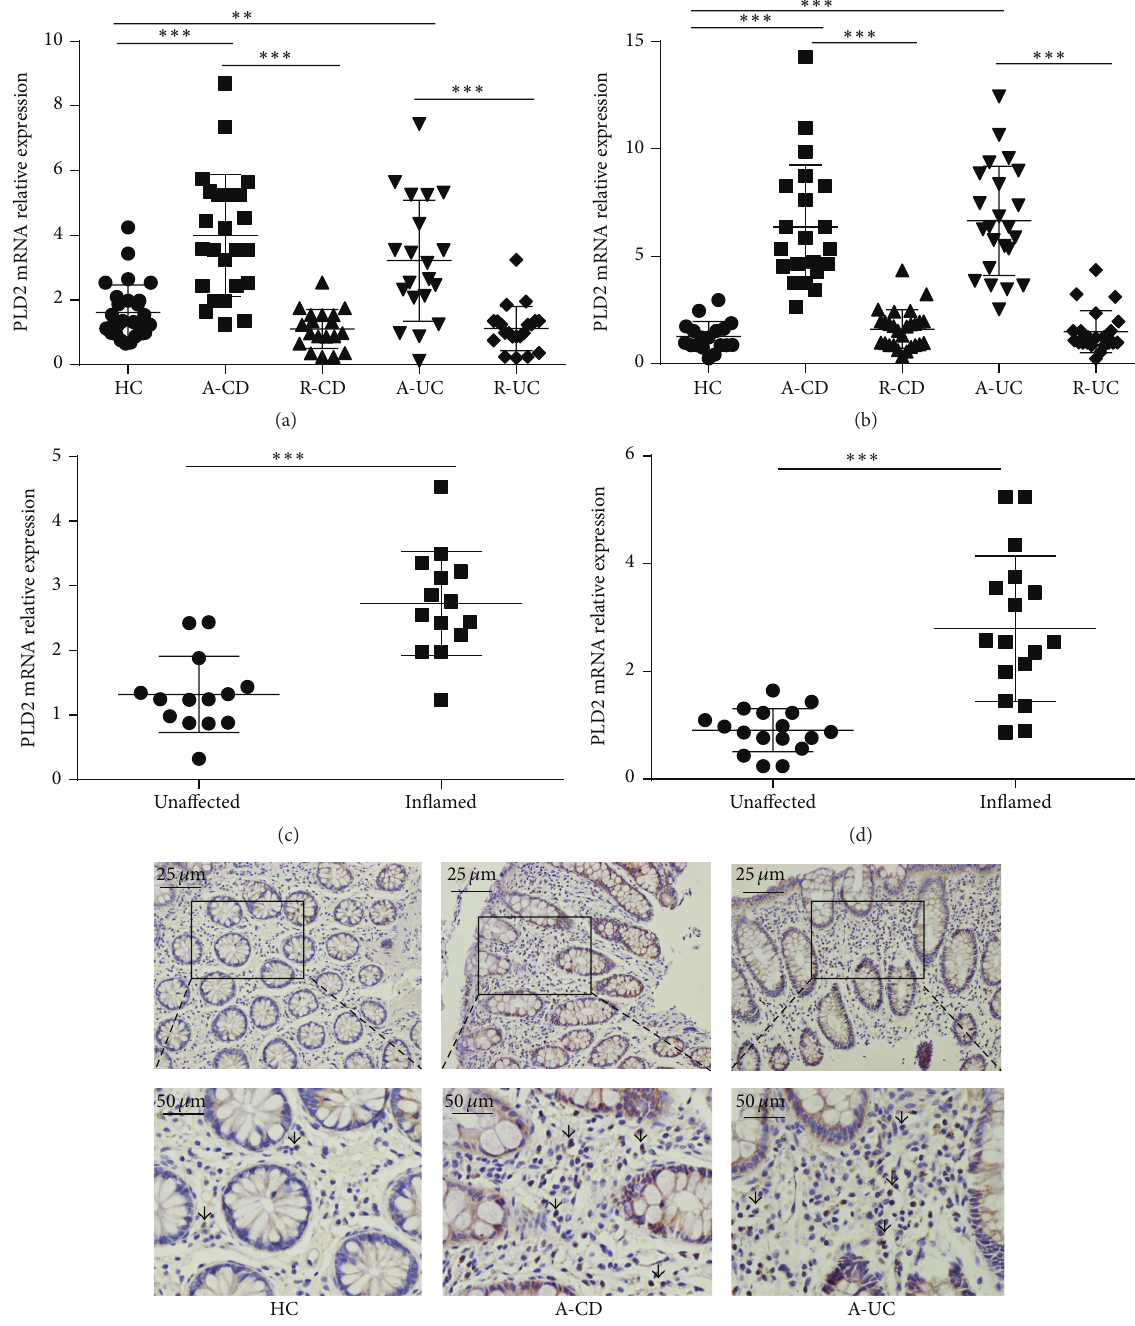
Figure 1: PLD2 is highly expressed in patients with active IBD. (a) Peripheral blood samples were collected from patients with active CD (A-CD, 𝑛 = 25 ), patients with CD in remission (R-CD, 𝑛 = 19 ), patients with active UC (A-UC, 𝑛 = 20 ), patients with UC in remission (R-UC, 𝑛 = 21 ), and healthy controls ( 𝑛 = 28 ). Expression of PLD2 mRNA was detected by qRT-PCR. (b) Colonic biopsies were collected from patients with A-CD ( 𝑛 = 21 ), R-CD ( 𝑛 = 27 ), A-UC ( 𝑛 = 26 ), R-UC ( 𝑛 = 26 ), and HC ( 𝑛 = 18 ). Expression of PLD2 mRNA was examined by qRT-PCR. Gene expression was normalized to GAPDH in each group. ∗∗ 𝑝 < 0.01 and ∗∗∗ 𝑝 < 0.001 versus HC. ((c) and (d)) Expression of PLD2 mRNA in inflamed and healthy intestinal mucosa from the same patients with A-CD ((c) 𝑛 = 14 ) and A-UC ((d) 𝑛 = 17 ) was examined by qRT-PCR. Gene expression was normalized to GAPDH in each group. ∗∗ 𝑝 < 0.01 and ∗∗∗ 𝑝 < 0.001 versus unaffected mucosa. (e) Representative images of immunohistochemical staining of PLD2 in inflamed colon from patients with A-CD, A-UC, and normal colonic mucosa from HC. Original magnification × 200 (top) and original magnification × 400